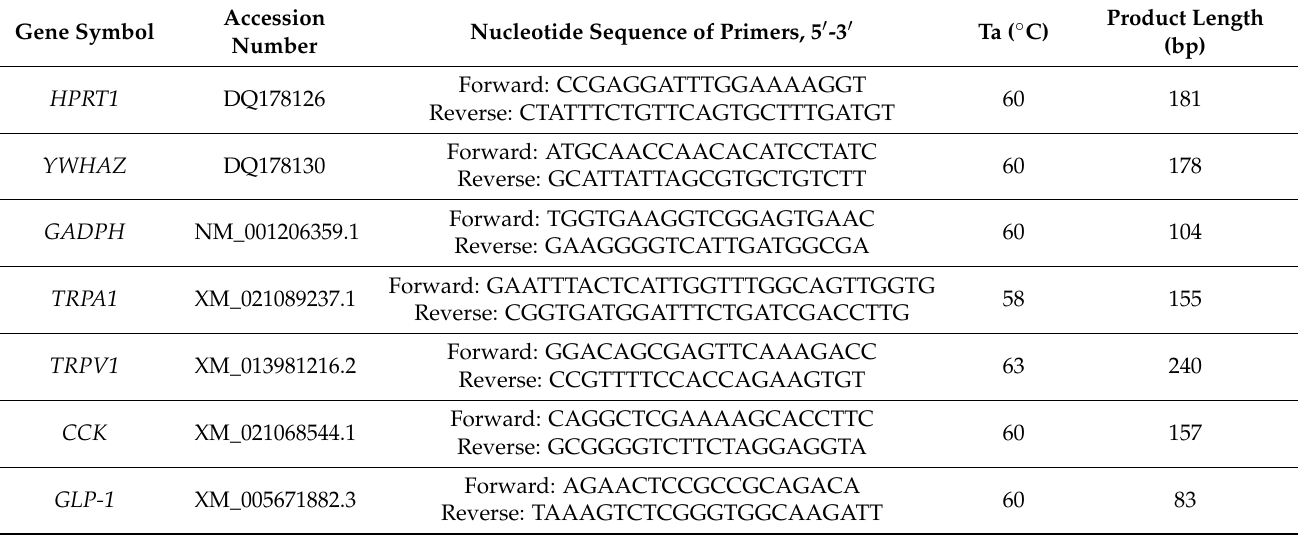
Table 1. Primers used for real-time PCR, annealing temperature (Ta), and amplicon